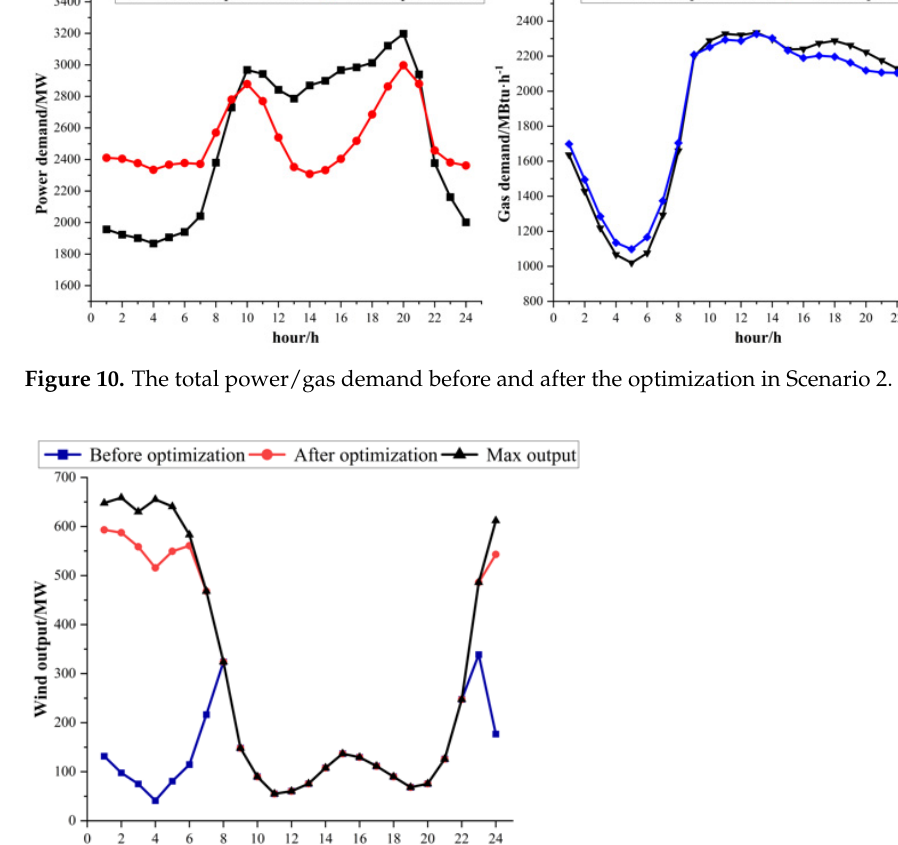
Figure 12. The energy supply cost, carbon trading cost, and carbon emissions of each EH before and after the optimization in Scenario 2. 4.2.3. Scenario 3: With Different Wind Penetration Rates To investigate the effect of the two-stage model on the IES with different renewable energy penetration rates, the carbon emissions and percentages of carbon emission reduc- tion after the optimization were studied with the wind power penetration rate (installed wind power capacity/system maximum system load) increasing from 20% to 80% in steps of 10%. As shown in Figure 13, an increase in the penetration rate led to the gradual re- duction in the system carbon emissions, and the percentage of carbon reduction after the optimization remained basically stable, with a slight increase from 6.2% to 6.8%.